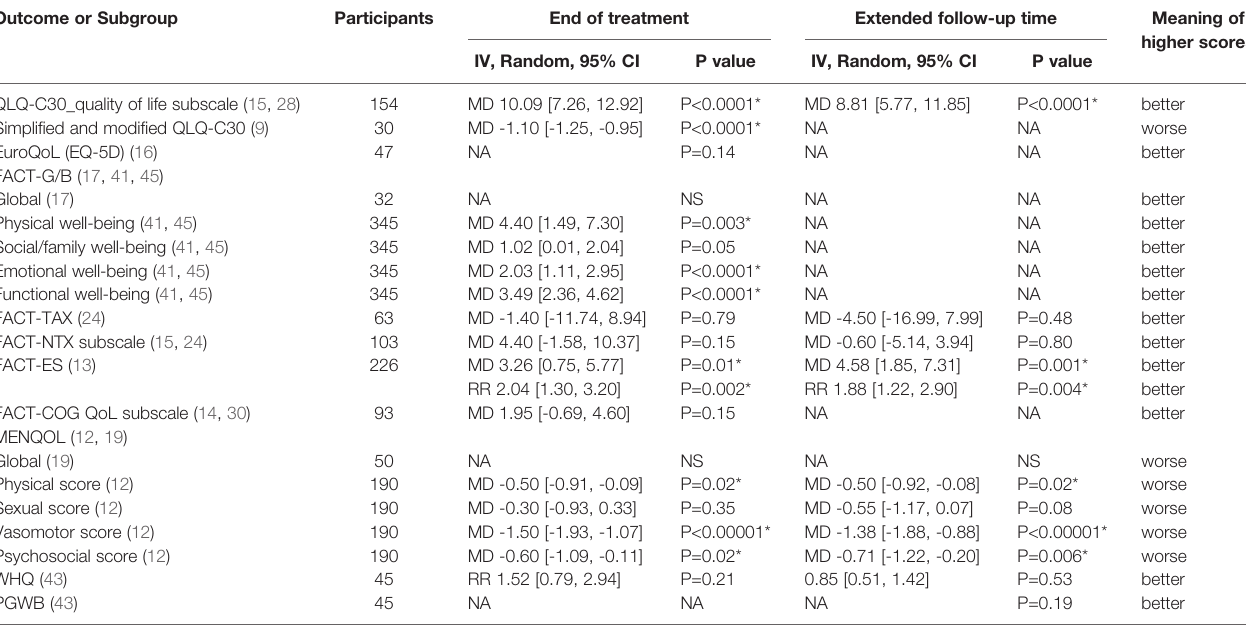
TABLE 1 | The QoL of acupuncture versus comparators for BC treatment-related symptoms. Outcome or Subgroup Participants End of treatment Extended follow-up